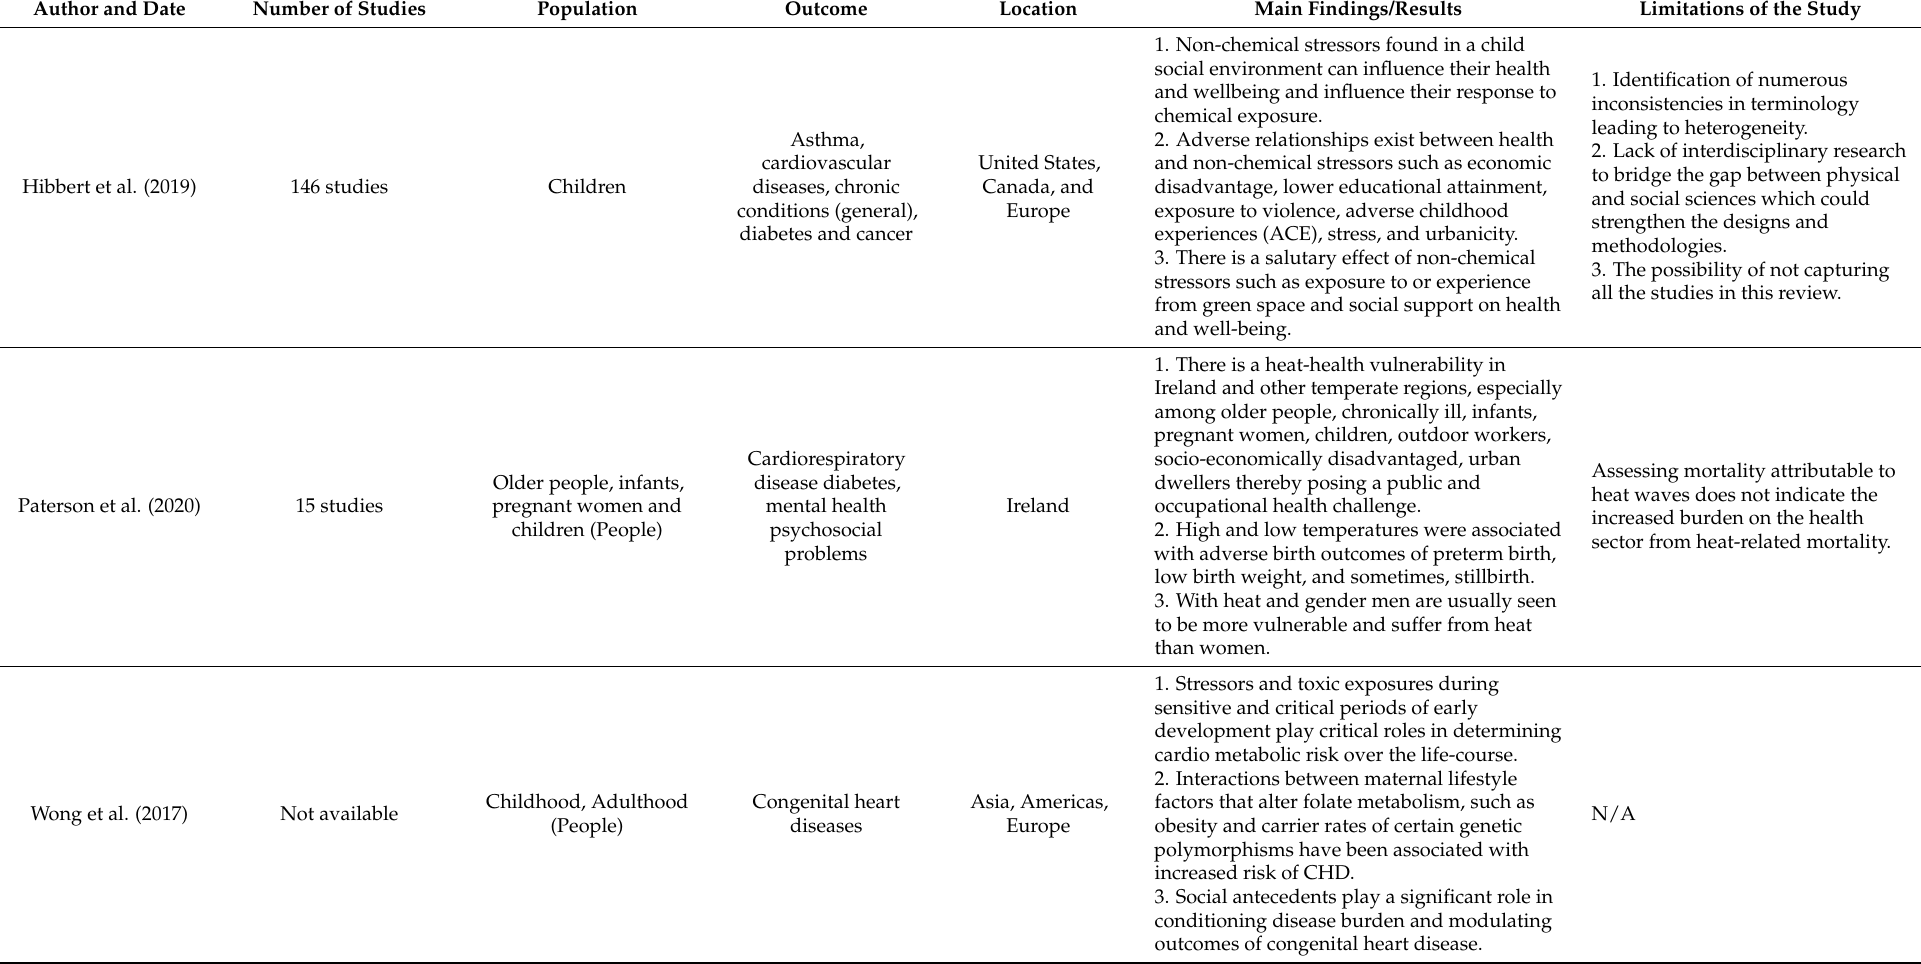
Table 1. Summary of the main characteristics of the selected